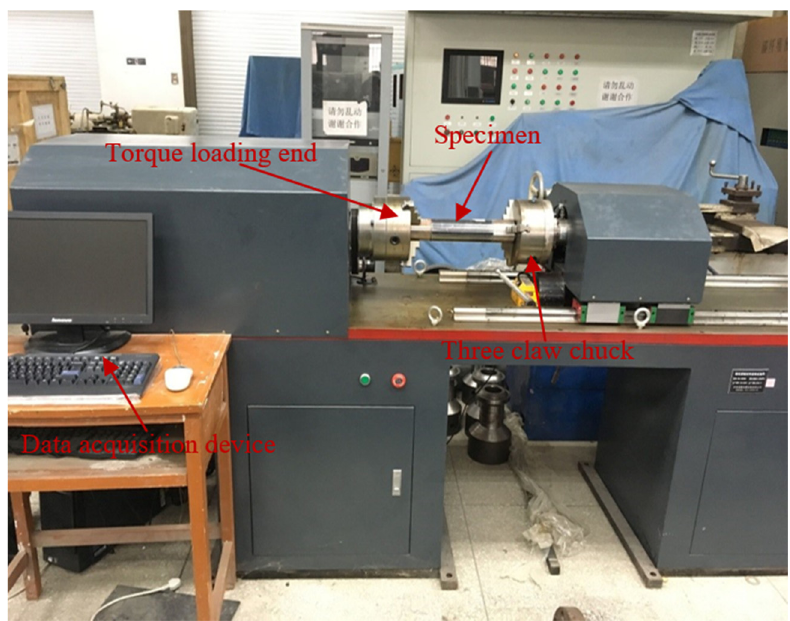
Figure 16: Interference fi t joint torsion measurement